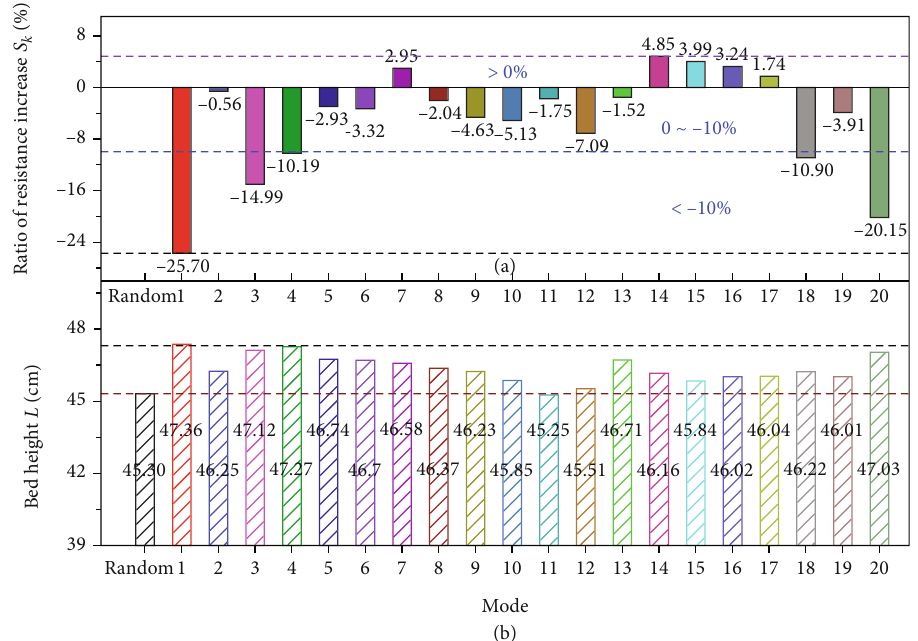
L (b) under di ff erent fi ve-layer layered Figure 11: The ratio of the resistance increase S k (a) and the total height of the sinter bed arrangement modes for the sinter mixture with the equivalent particle diameter of